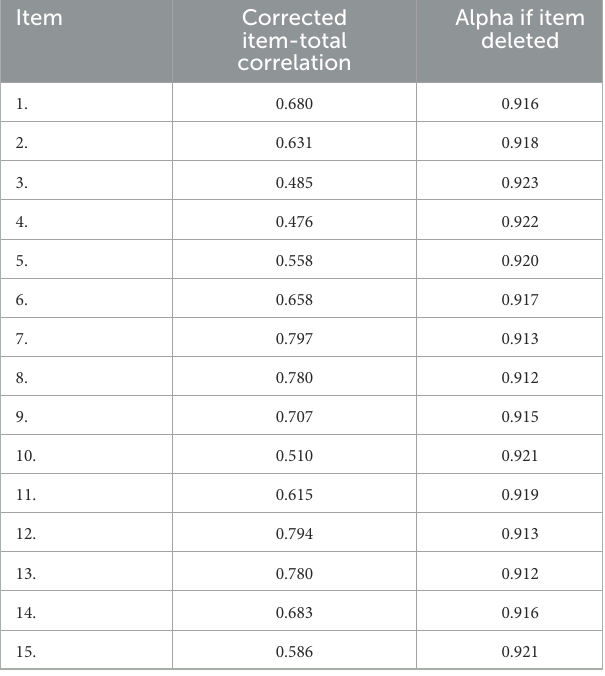
TABLE 3 Internal consistency of C-UEFI ( N =